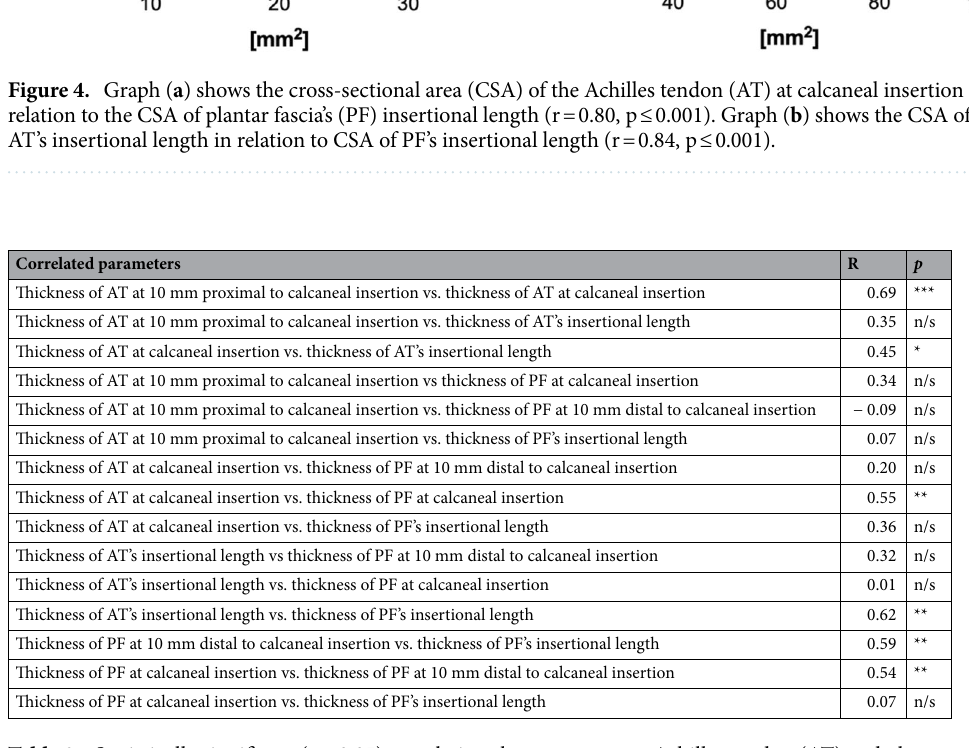
Table 2. Statistically significant (p ≤ 0.05) correlations between average Achilles tendon (AT) and plantar fascia (PF) thicknesses. P, p-value; r, correlation coefficient; n/s, not significant. *p ≤ 0.05, **p ≤ 0.01, ***p ≤ 0.001.